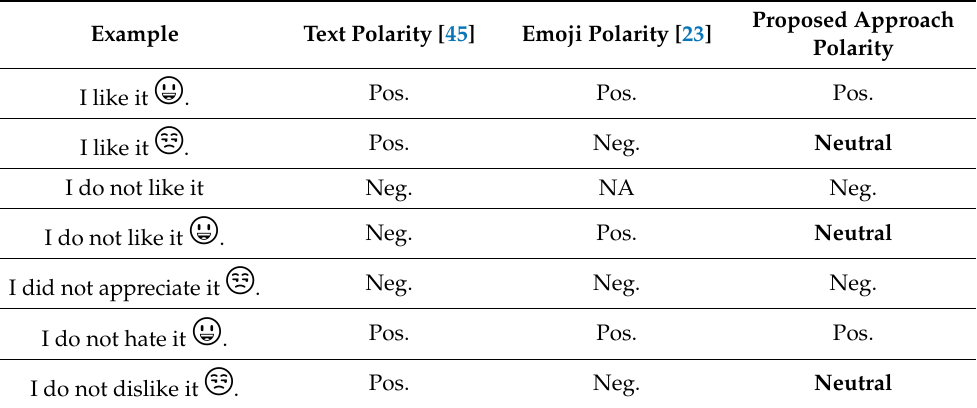
Table 3. Polarity inversion pattern sample.